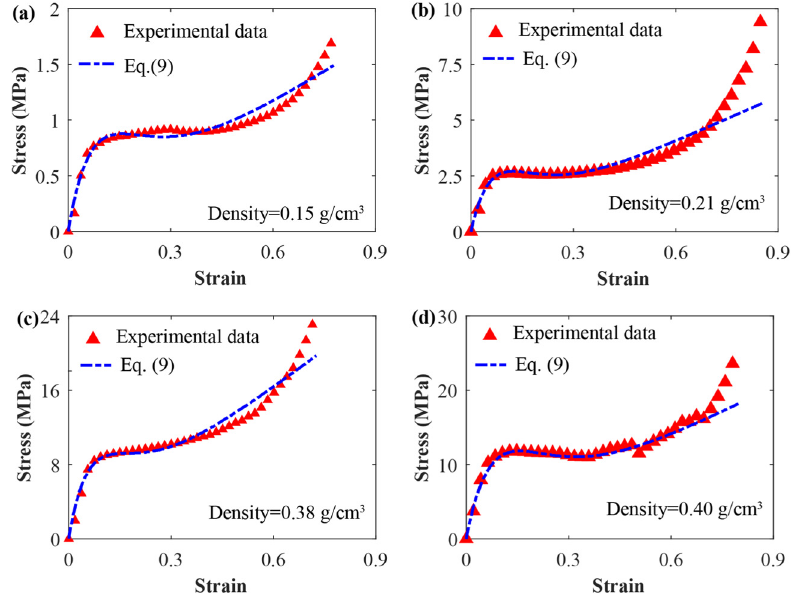
Figure 8: The experimental and theoretical stress – strain curves of the TFPU grouting materials with di ff erent densities: ( a ) 0.15 g · cm − 3 , ( b ) 0.21 g · cm − 3 , ( c ) 0.38 g · cm − 3 , and ( d ) 0.40 g · cm − 3 . The theoretical ones were drawn according to equation ( 9 )